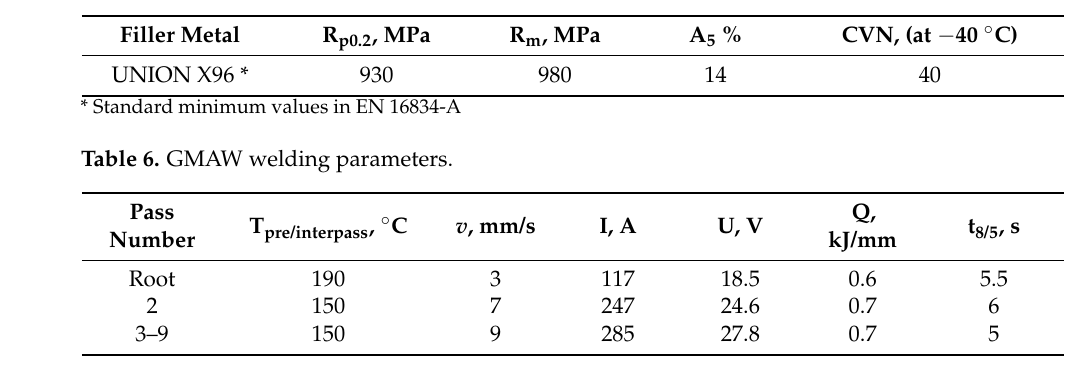
Table 5. Guaranteed mechanical properties of investigated filler metal.